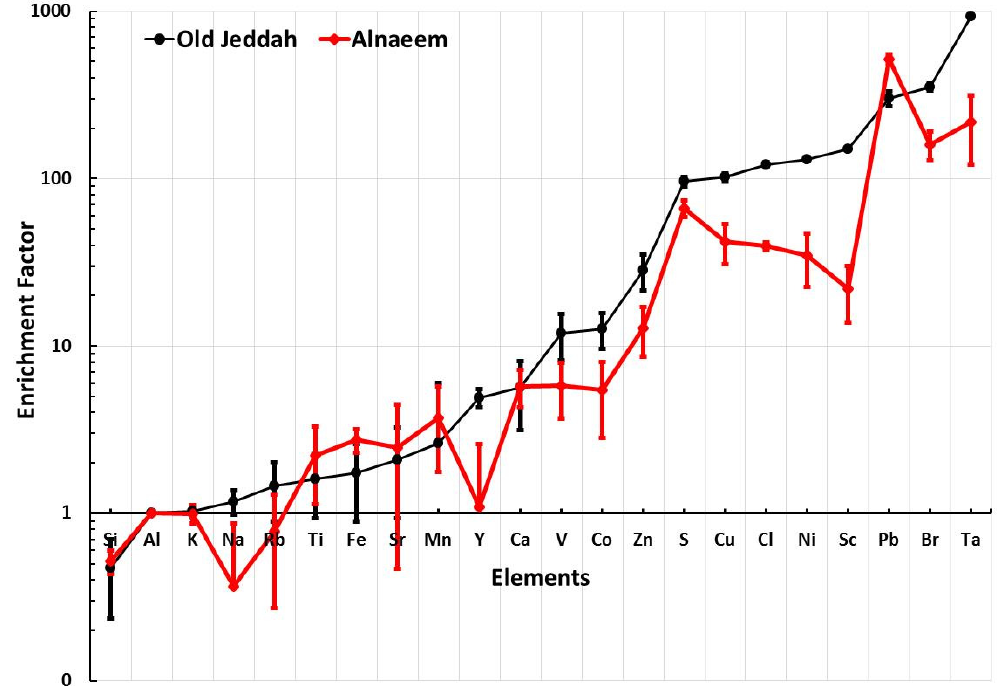
Figure 9. Enrichment factors of the determined elements in the PM 2.5 samples assembled from the historical Jeddah and Alnaeem locations.